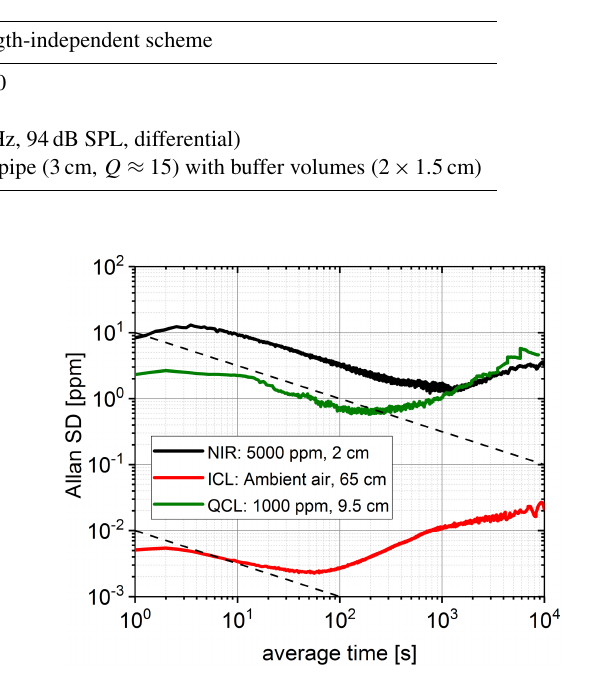
Figure 5. Allan plots for the NIR, ICL and QCL measure- ments. The Allan deviations are measured for different cell lengths and concentrations. The reduction of the Allan data for integration times < 5s is caused by the moving average of the DAS data acquisition procedure. Dashed black lines indicating a typical √ τ dependence for white noise are shown as guides for the 1 /